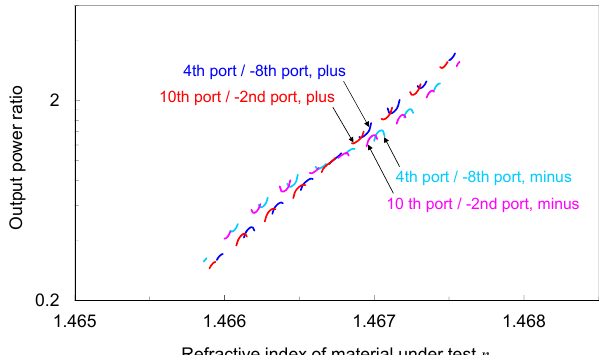
Figure 7. Output power ratio for 4th port / –8th port and 10th port / –2nd port as a function of n t . The power ratio is calculated using the relative output power, i.e., the difference between the output power and power if only the broad beam exists.